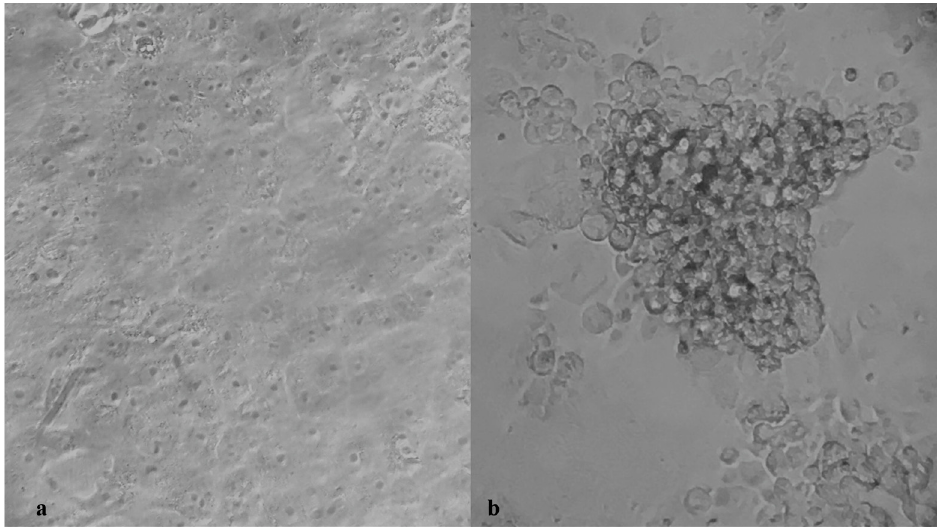
Figure 1. Viral cytopathic effect (CPE) ( b ) observed in cultured Vero E6 cells after infection with 100 TCID of the SARS-CoV-2 strain. ( a ) shows the uninfected control cells. (Magnification 400×).